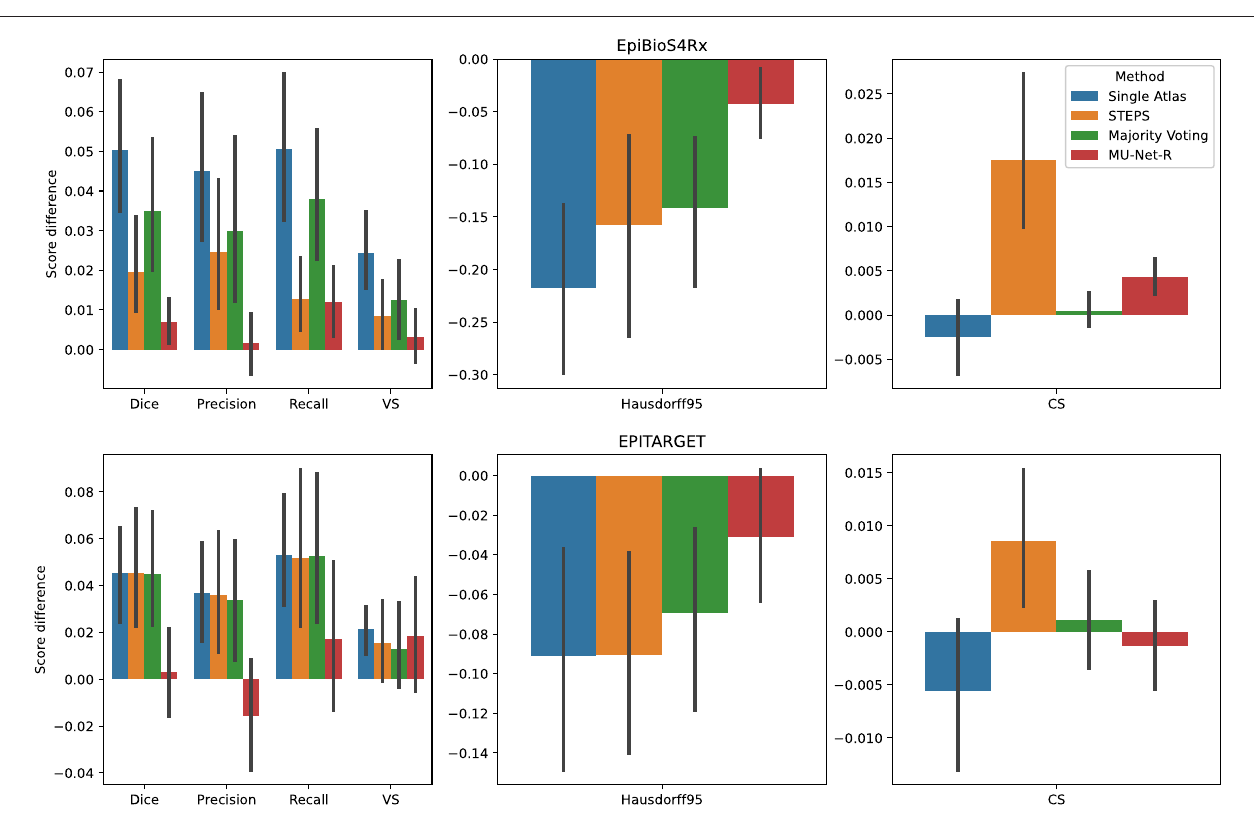
FIGURE 6 | Mean inter-hemispheric differences for all evaluation metrics in single-atlas, STEPS, Majority Voting and MU-Net-R segmentation. Error bars correspond to 95% bootstrapped confidence intervals for the mean. MU-Net-R minimizes inter-hemispheric performance differences across all metrics and on both the EpiBioS4Rx and EPITARGET datasets, with the exception of CS on the EpiBioS4Rx dataset.